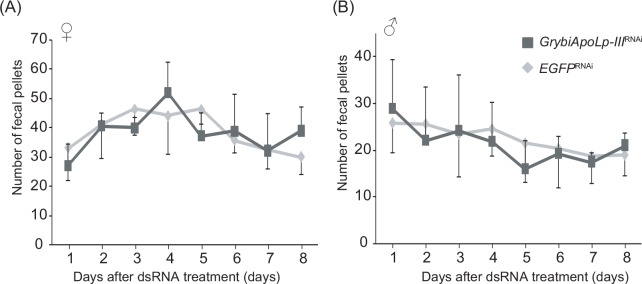
Effect of G. bimaculatus ApoLp-III knockdown on food intake.Food intake of GrybiApoLp-IIIRNAi adult females (A) and males (B). The amount of food intake was evaluated by counting the number of fecal pellets as previously observed [23]. There were no significant differences between dsGrybiApoLp-III-treated crickets and dsEGFP-treated crickets (P > 0.1 by Tukey’s PSD test). Values are mean ± SD (n = 6).